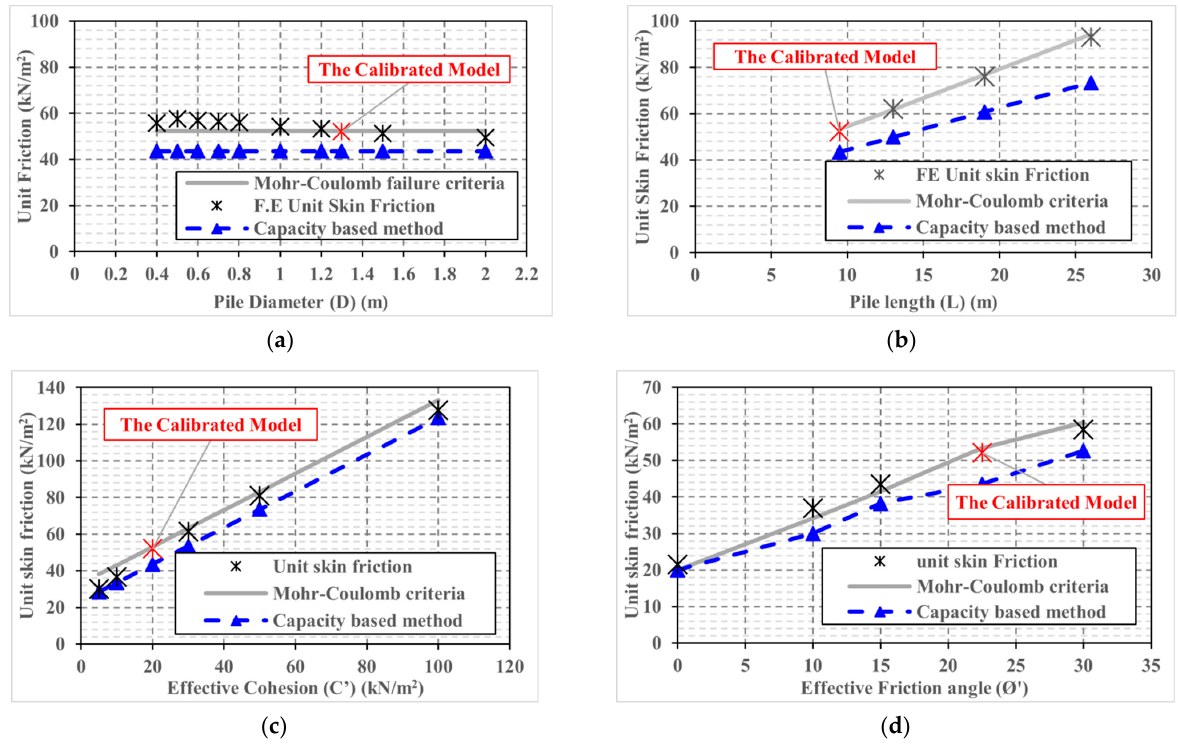
Figure 8. Variation of the average unit skin friction with various parameters. ( a ) Pile diameter (D). ( b ) Pile length (L). ( c ) Soil effective cohesion (c’). ( d ) Soil effective friction angle (Ø’).